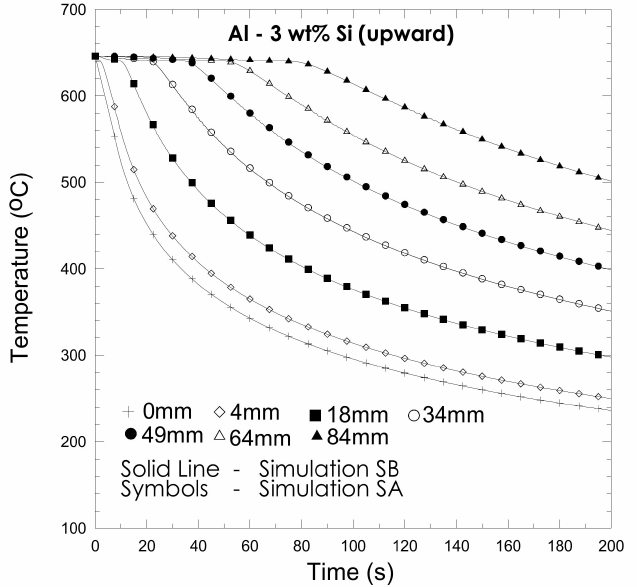
Figure 6. Comparison of transient temperature distributions between simulations SA and SB at r = 0 for various locations: y = 0, 4, 18, 34, 49, 64, and 84 mm (shown in Figure